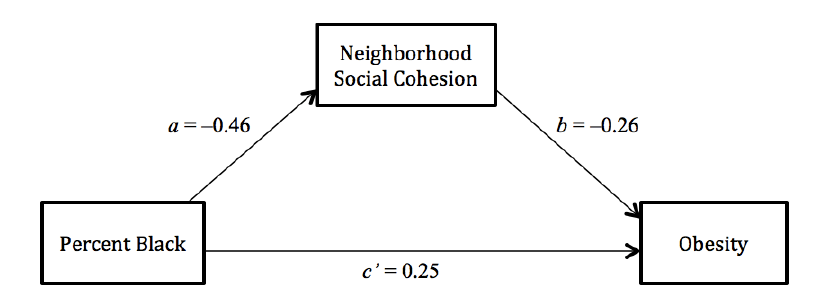
Figure 1. Path diagram depicting neighborhood social cohesion as the mediator between black concentration and obesity among white women.